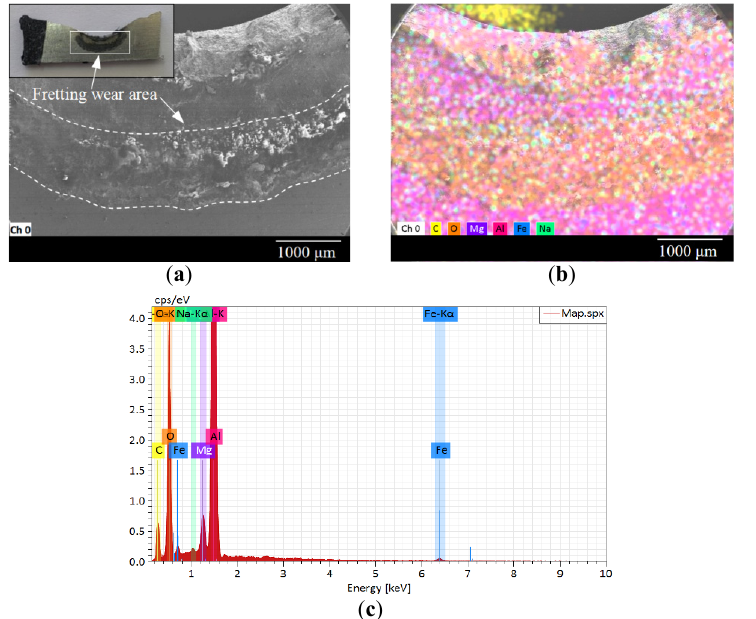
Figure 16. Morphology of contact interface between sheets. ( a ) Morphology of contact interface; ( b ) element composition; ( c ) mass fraction of the elements. ( b ) element composition; ( c ) mass fraction of the